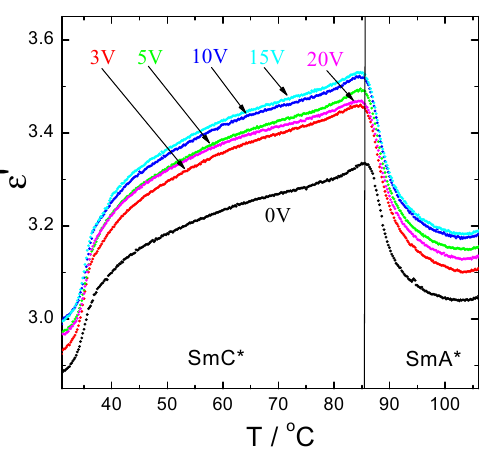
Figure 9. Three-dimensional-plots of the imaginary part of complex permittivity versus frequency and temperature measured on cooling for: the pure PE film ( a ), pure FLC compound ( b ), and stretched porous PE-FLC nanocomposite ( c ).